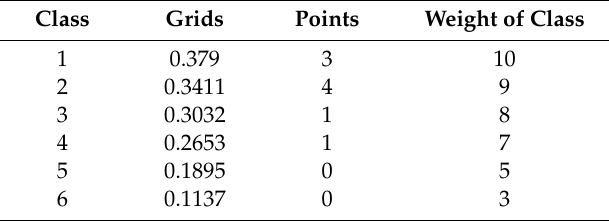
Table 7. Reclassification of depth by assigned